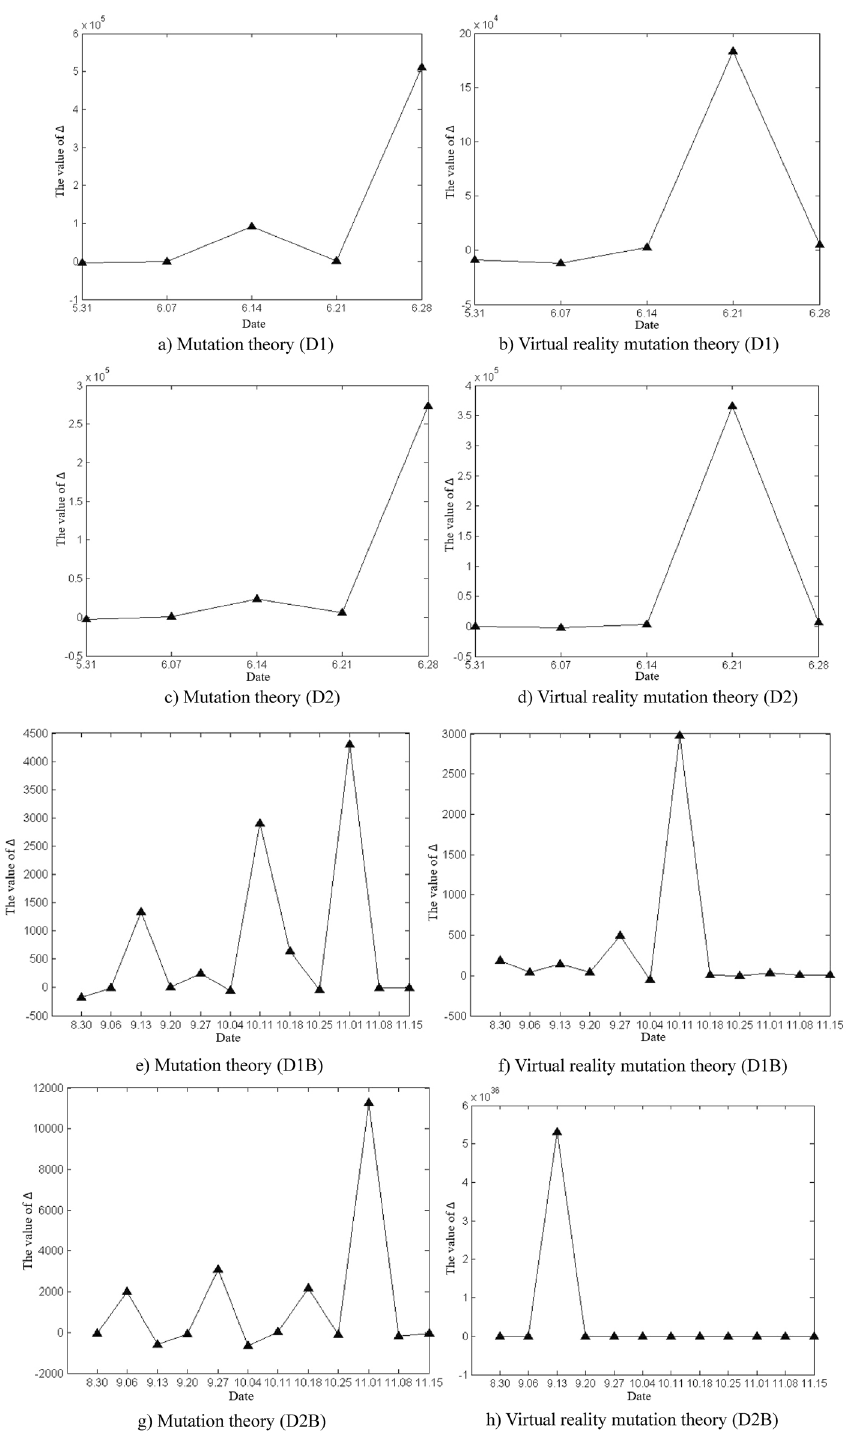
Figure 12. Time variation curve of the Δ